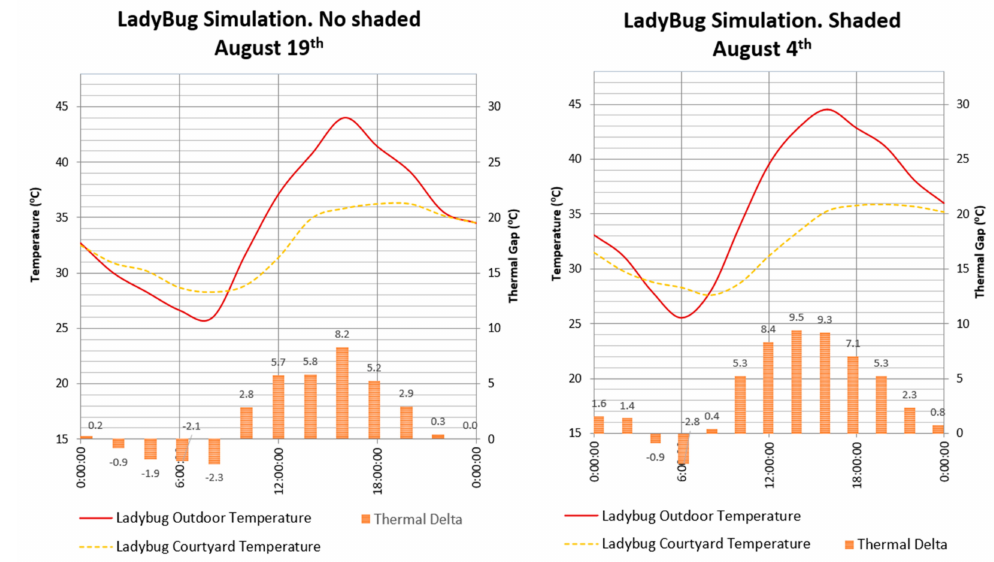
Figure 6. Ladybug-simulated outdoor and courtyard air temperatures on the selected days.